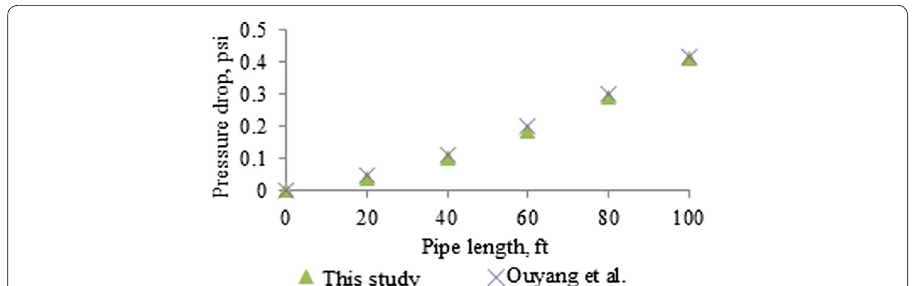
Fig. 7 Verification with Ouyang et al. (1997). Pressure development inside of the horizontal